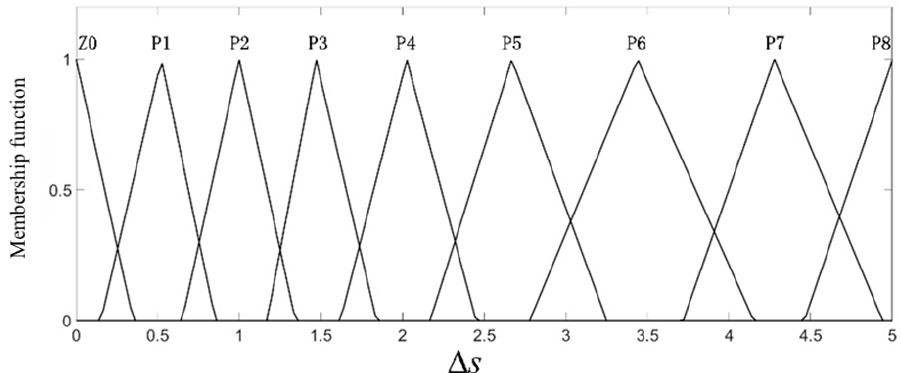
Sensors 2019 , 19 , x Figure 9. The membership function of the longitudinal relative distance. Figure 9. The membership function of the longitudinal relative distance.